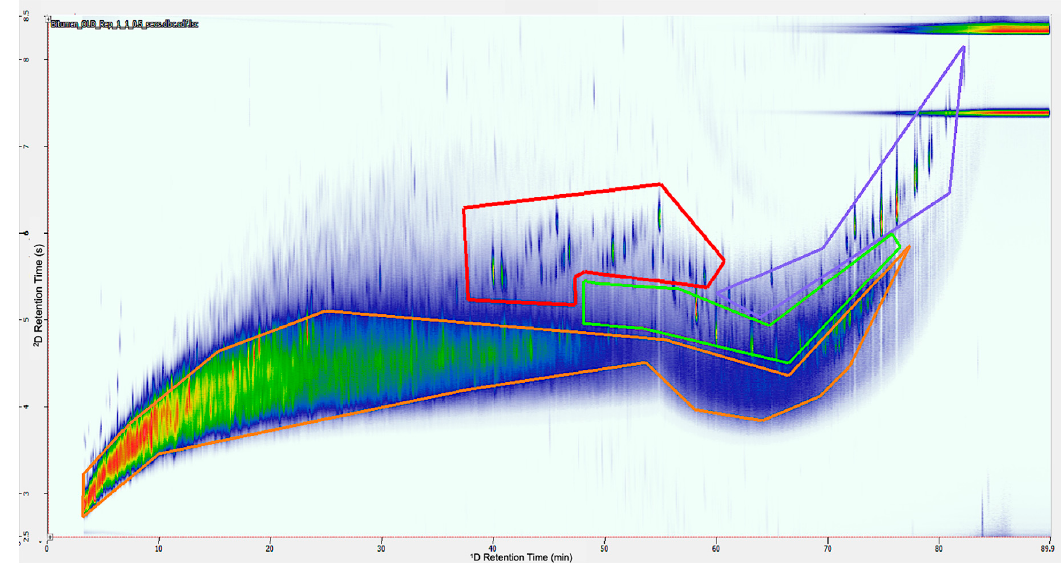
Figure 3. Group type identification of bitumen oil sands extracted with cyclohexane. The various colored boxes correspond to specific groups: paraffins ( orange ), alkylated steranes ( red ), terpanes ( green ) and hopanes ( purple ).